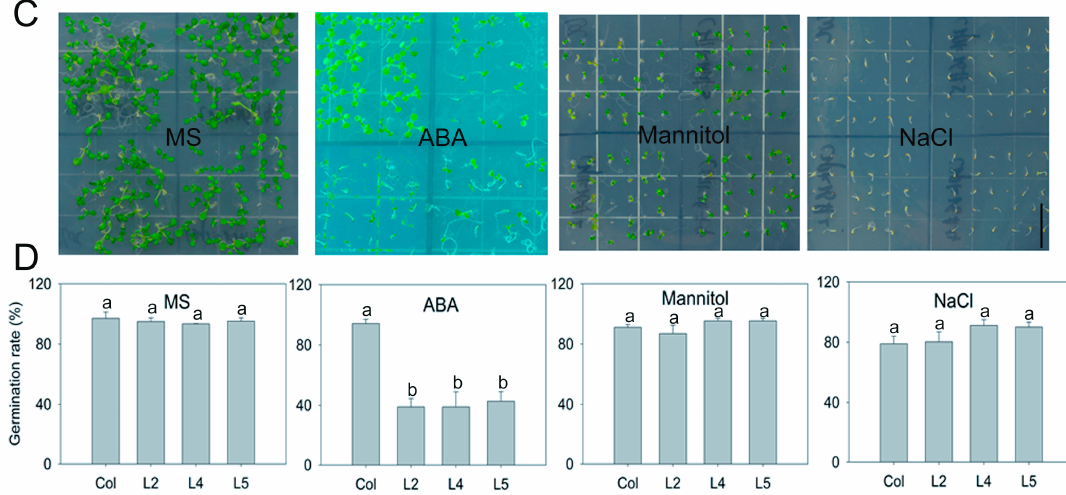
Figure 7. Effect of ABA on the root length, stress tolerance and germination of SpCIPK26 -OXP. ( A ) Effect of ABA and its inhibitor sodium tungstate (WS) on the seedling growth under normal or stress condition. Photograph was taken of seven-day-old seedlings from each line; ( B ) root length of seedlings presented in ( A ); ( C ) germination of SpCIPK26 -OXP and WT seeds sown on half MS containing 0.2 μ M ABA, 200 mM mannitol and 150 mM NaCl; ( D ) Germination percentage of seedlings presented in ( C ) and the number of seedlings was counted as emergence of cotyledon. All experiments were replicated three times and each column represent means ± SD. Error bar denotes standard deviation, and different letters above the bars signify significant difference between wild type (control, Col) and transgenic lines (L2, L4 and L5) at p < 0.01. Bars = 1 cm.